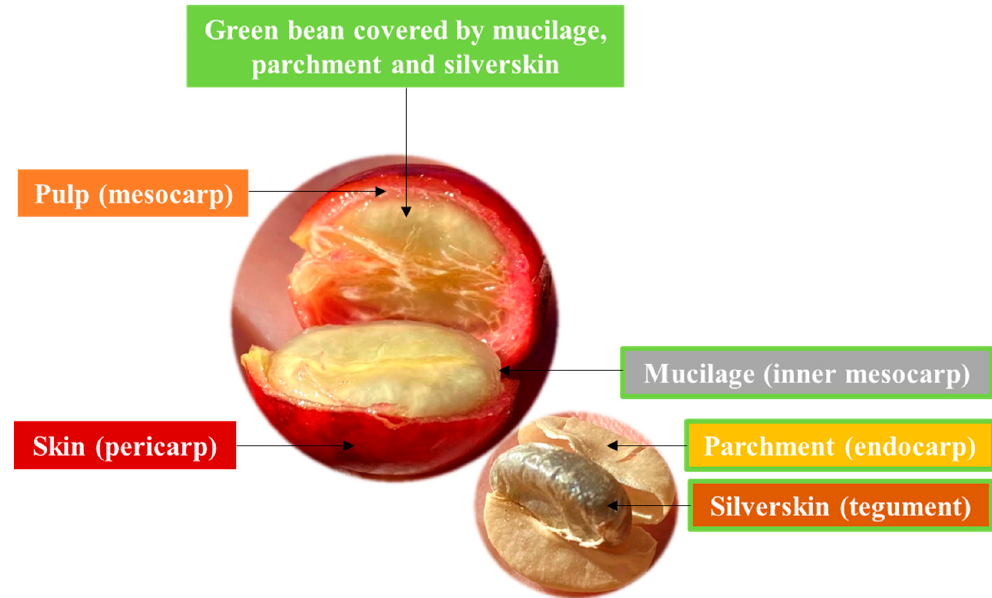
Figure 1. Identification of coffee by-products in the coffee cherry anatomy.